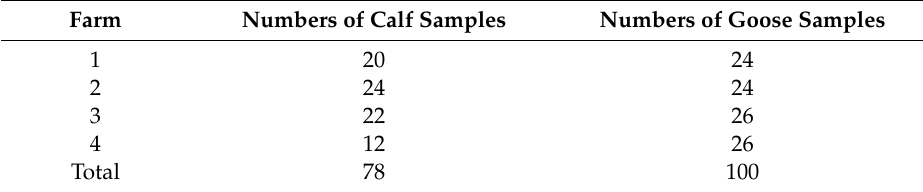
Table 3. Numbers of calf and goose samples collected from each